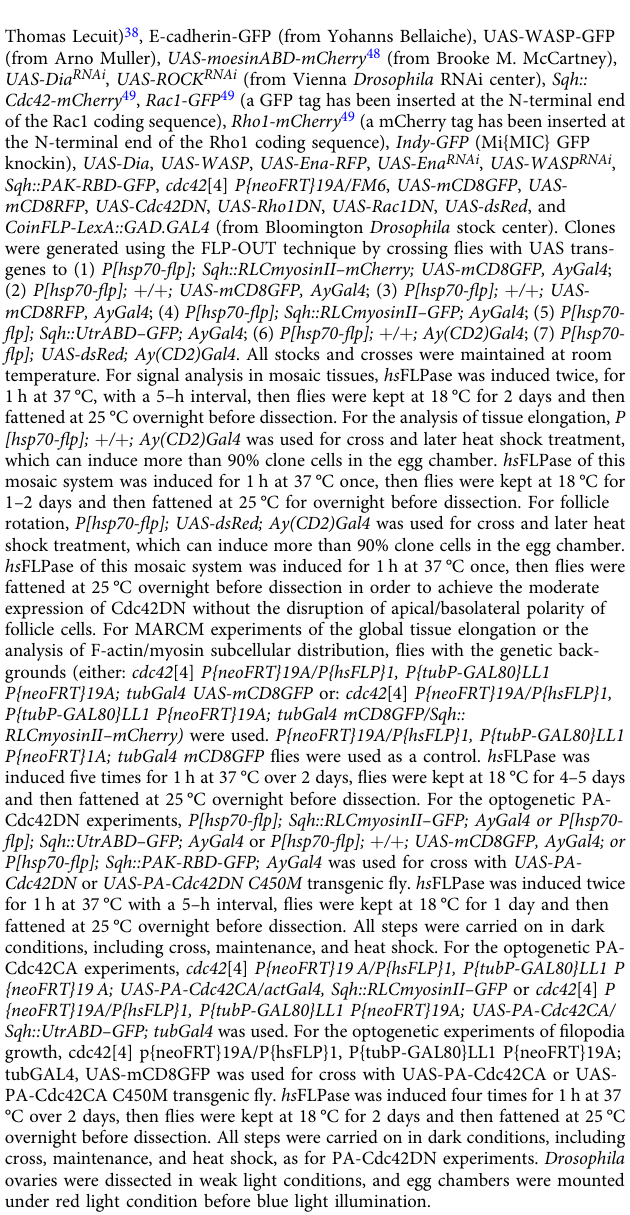
Fig. 4 Optogenetics reveal speci fi c spatial and temporal control of Cdc42. a Schematic diagram showing the mechanism of PA-Cdc42 photoactivation by blue light ( hv ). b , d , e , f , g . Time-lapse series of representative mCherry-tagged PA-Cdc42DN-expressing ( b , d , e ) and mCherry-tagged PA-Cdc42CA- expressing follicle cell with cdc42 [4] mutant genetic background ( f , g ), labeled with mCD8GFP ( b ), MyoII-GFP ( d , f ) and UtrABD-GFP ( e , g ). PA indicates the time of photoactivation. Arrow heads indicate fi lopodia in b . c Average fi lopodia length per cell (from seven egg chambers) in the n individual PA- Cdc42DN clone cells before and 10 – 15 min after photoactivation. p = 0.0099 by two-sided Mann – Whitney test. d , e , f , g (central panel). Relative (central/ lateral) distribution over time of MyoII ( d , f ) and F-actin ( e , g ) for a representative case in the indicated genetic backgrounds. d , e , f , g (right panel). Relative (central/lateral) distribution of MyoII ( d , f ) and F-actin ( e , g ) before and 25 – 30 min after photoactivation in the n individual cells under the indicated genetic backgrounds. For MyoII signal, the PA-Cdc42DN before- vs. after- photoactivation comparison: p < 0.0001, the PA-Cdc42DN C450M before- and after- photoactivation comparison: p = 0.7107; for F-actin signal, the PA-Cdc42DN before- vs. after- photoactivation comparison: p = 0.0005, the PA-Cdc42DN C450M before- and after- photoactivation comparison: p = 0.972; for MyoII signal, the PA-Cdc42CA before- vs. after- photoactivation comparison: p = 0.0022; for F-actin signal, the PA-Cdc42CA before- vs. after- photoactivation comparison: p = 0.0006; all by two-sided Mann – Whitney test. Data are presented as mean values + / − SEM. Scale bars are 5 μ m in b , d , e , f ,